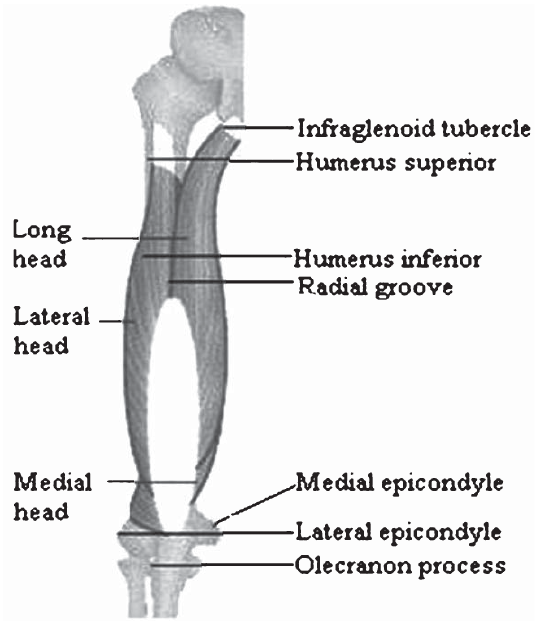
Fig. 1. Anatomical locations of the triceps brachii muscle (left side: mentioning the muscle locations, right side: mentioning the bone